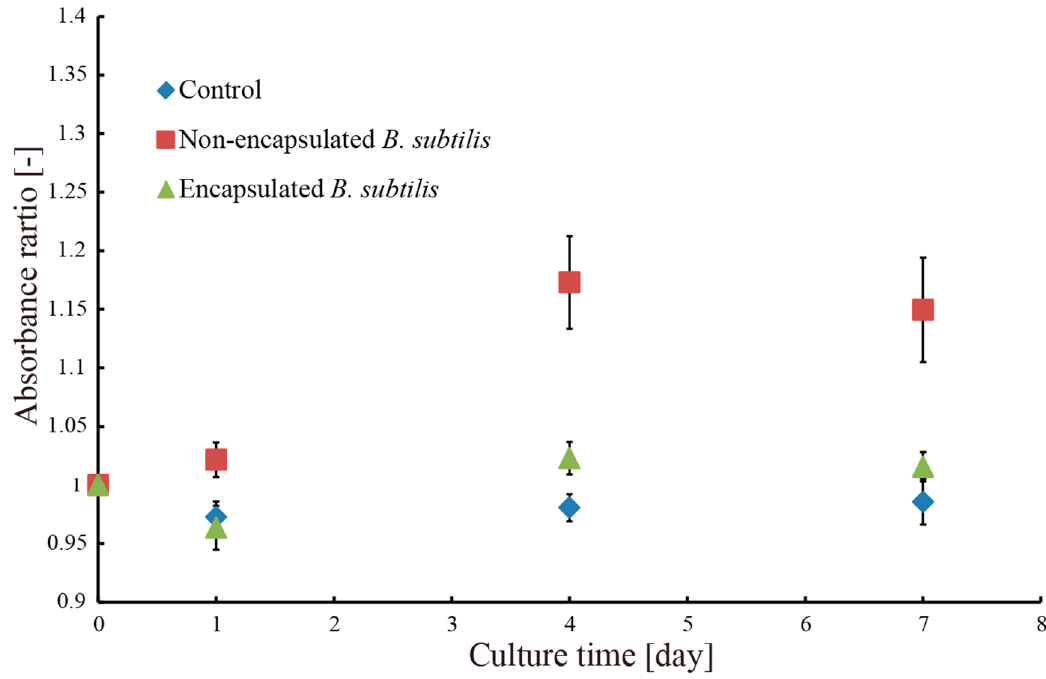
Figure 11. Relationship between the concentration of microbes in the methylene blue solution and culture time.